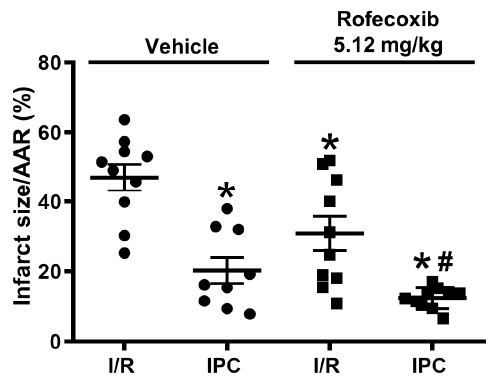
Figure 7. Chronic rofecoxib treatment reduced infarct size and did not interfere with cardioprotection by ischemic preconditioning. (* p < 0.05 vs. I/R + vehicle, # p < 0.05 vs. I/R + rofecoxib, n =